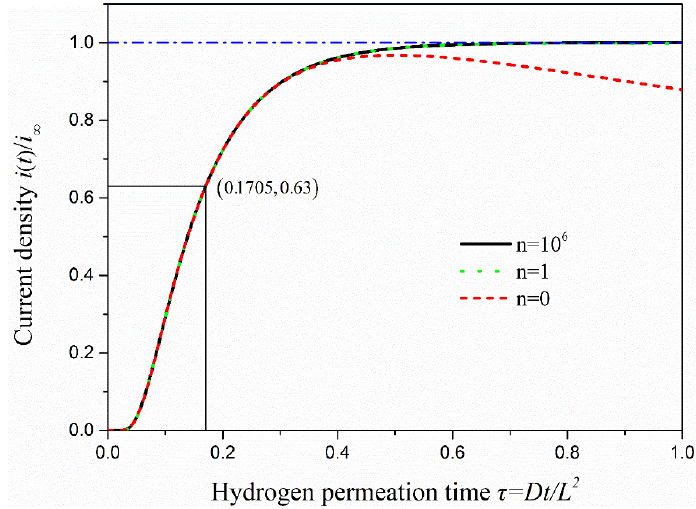
Figure 6. The curve of oxidation current density with hydrogen permeation time under the hydrogen permeation model.